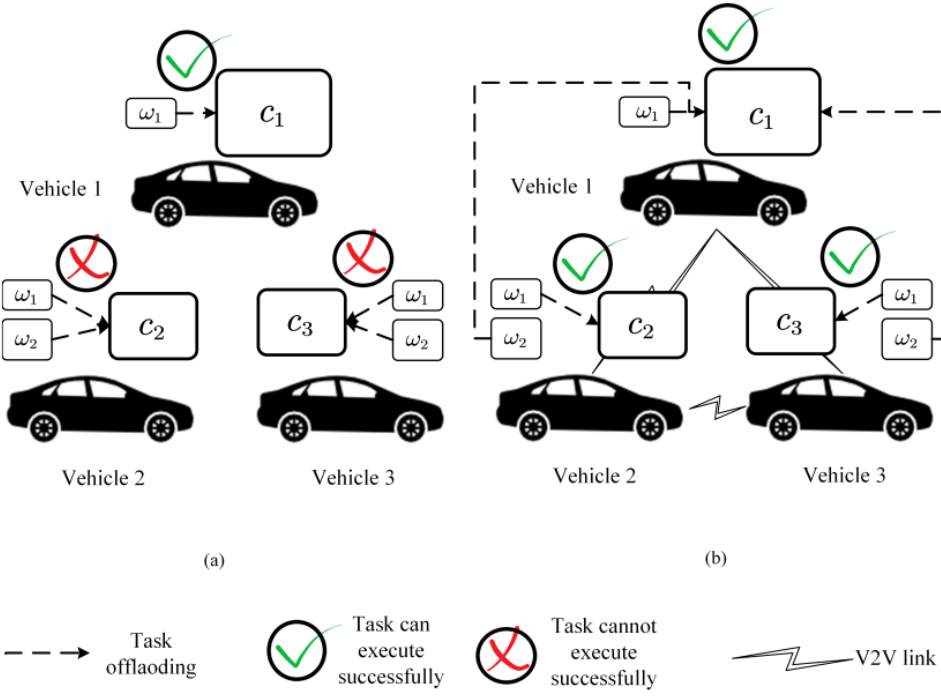
Figure 3. Road safety improvement via task scheduling in cooperative perception. ( a ) No task sched- uling performed. ( b ) Conduct task scheduling. scheduling performed. ( b ) Conduct task